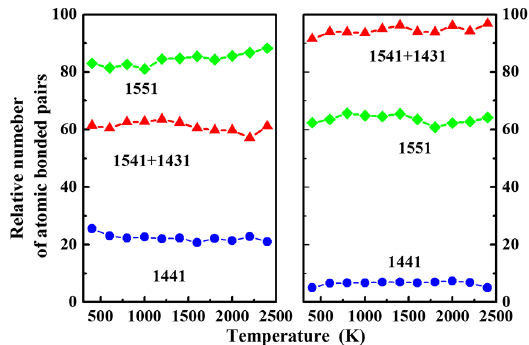
Figure 5. Relative number of various bonded pairs with the temperature. Left: 1.4 GPa. Right: 4 GPa.